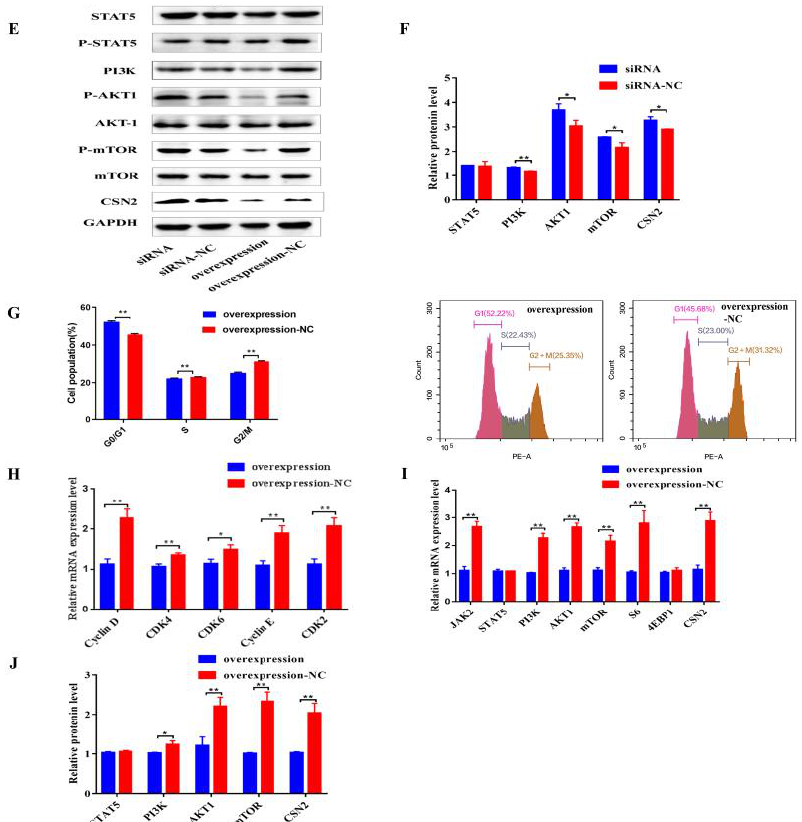
Figure 6. CDKN1A regulates BMECs cell cycle and milk protein synthesis through PI3K/AKT/mTOR pathways of BMECs. ( A ) Screening of the best inhibiting fragment and time of three siRNA. ( B ) Distri- bution of cell cycle phases of BMECs with PI staining after interference on CDKN1A for 48 h. ( C ) The mRNA expression of cell cycle regulators specific to G1/S phase in BMECs when CDKN1A was down- regulated with qRT-PCR. ( D – F ) The mRNA and protein expression levels of eight genes in protein synthesis after interference on CDKN1A in BMECs. ( G ) Distribution of cell cycle phases of BMECs with PI staining after over-expression of CDKN1A . ( H ) The mRNA expression of cell cycle regulators specific upon over-expression of CDKN1A . ( I , J ) The expression of eight genes involved in protein synthesis after up-regulation of CDKN1A. (Note: * means p value < 0.05; ** means p value <